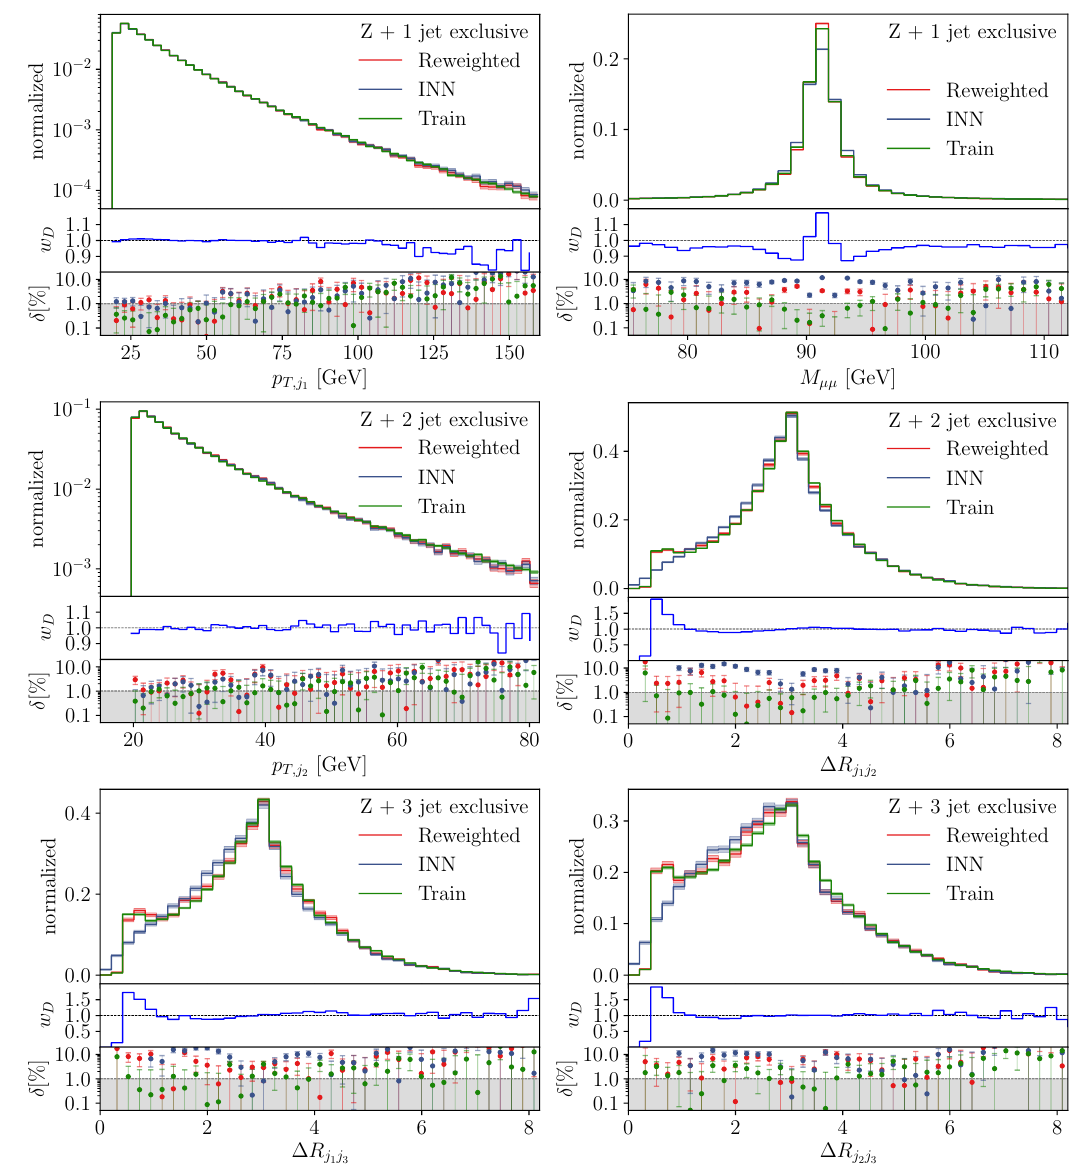
Figure 5: Discriminator-reweighted INN distributions for Z + 1 jet (upper), Z + 2 jets (middle), and Z + 3 jets (lower) from a combined Z + jets generation. The bottom panels show the average correction factor obtained from the discriminator output, the INN results without reweighting are the same as in Fig. 4, except for slightly longer